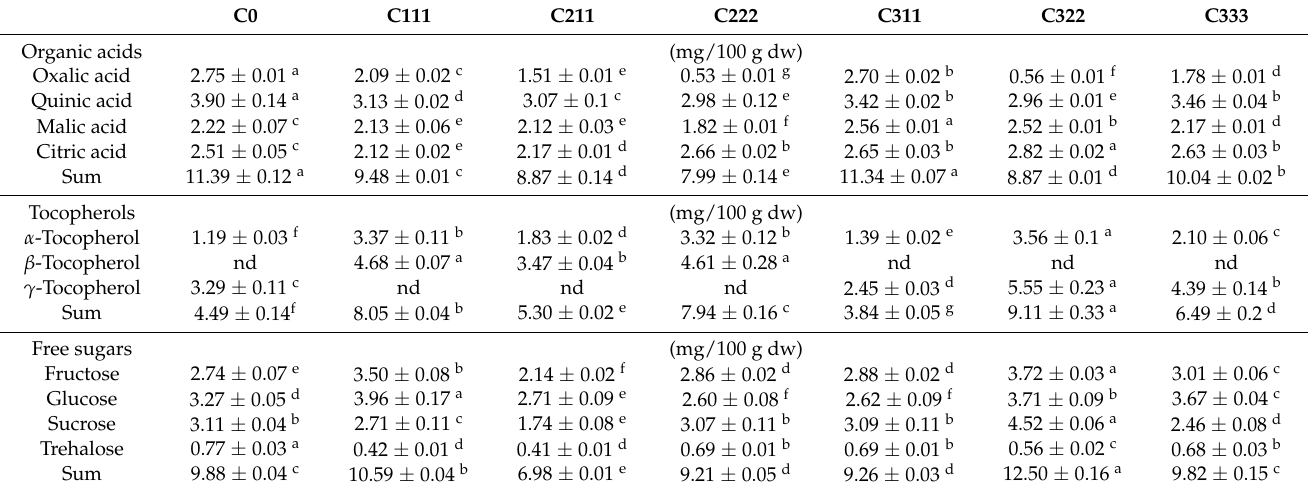
Table 3. Organic acid, tocopherol, and free sugar content of C. spinosum (mean ±